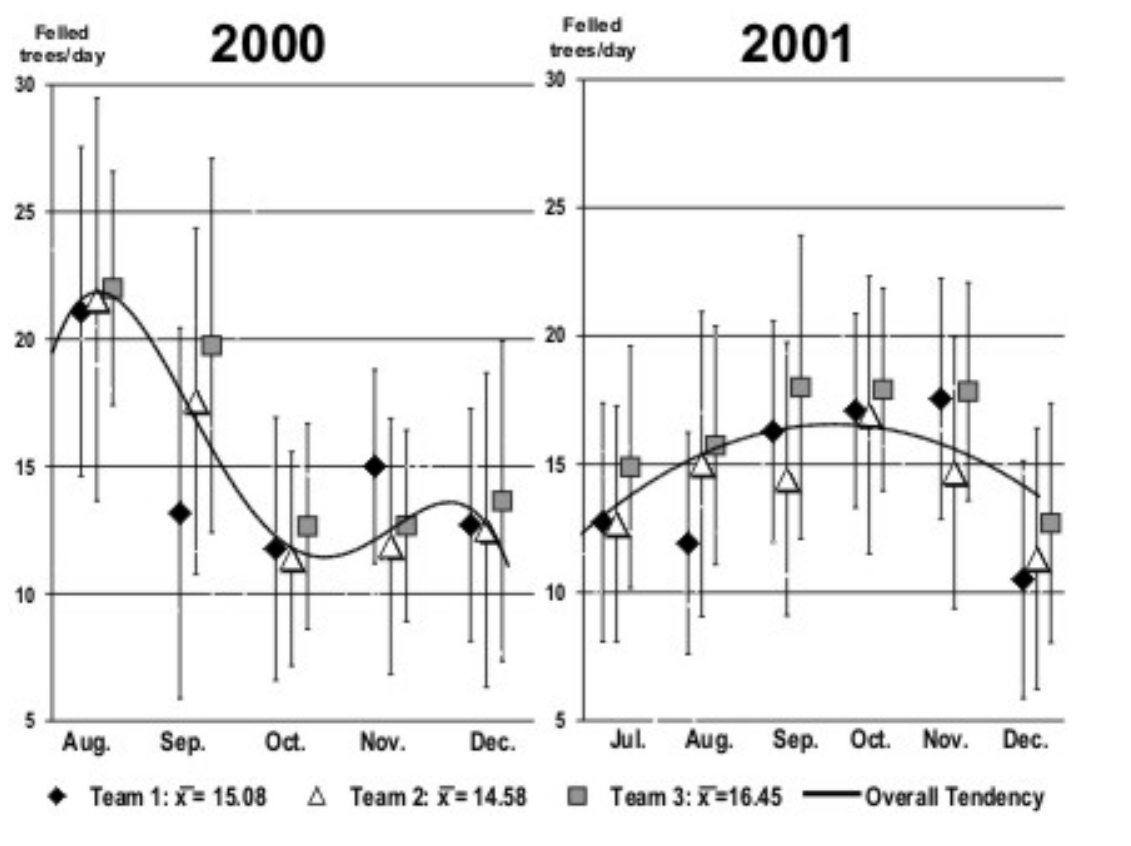
Fig. 3 . Daily production and overall means of three felling teams during the harvest periods 2000 and 2001, affected by the implementation of directional felling as part of RIL in September